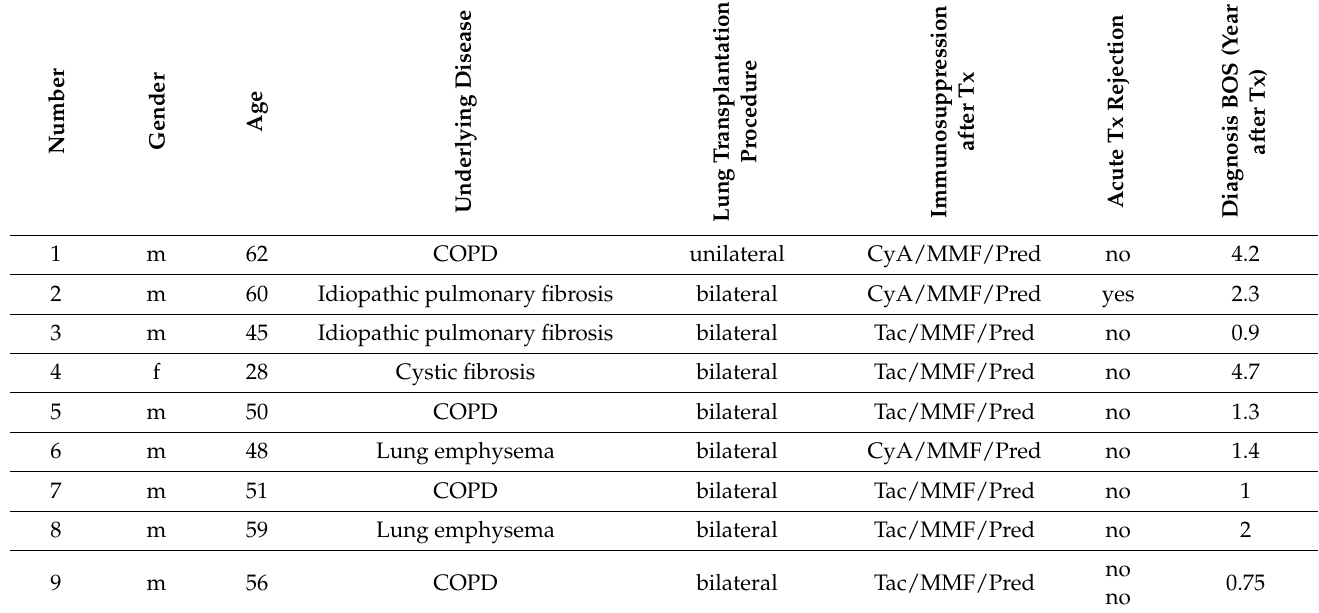
Table 3. Overview of all patients with BOS after lung